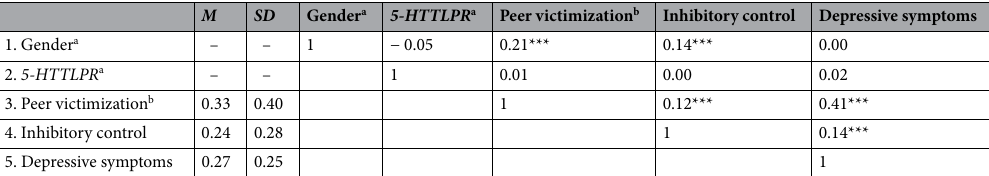
Table 1. Means, standard deviations, and correlations among the primary variables. * p < 0.05; ** p < 0.01; *** p < 0.001. a 5-HTTLPR genotype and Gender were dummy coded: SS = 0, L = 1; Girls = 0 and Boys = 1. b Peer victimization was